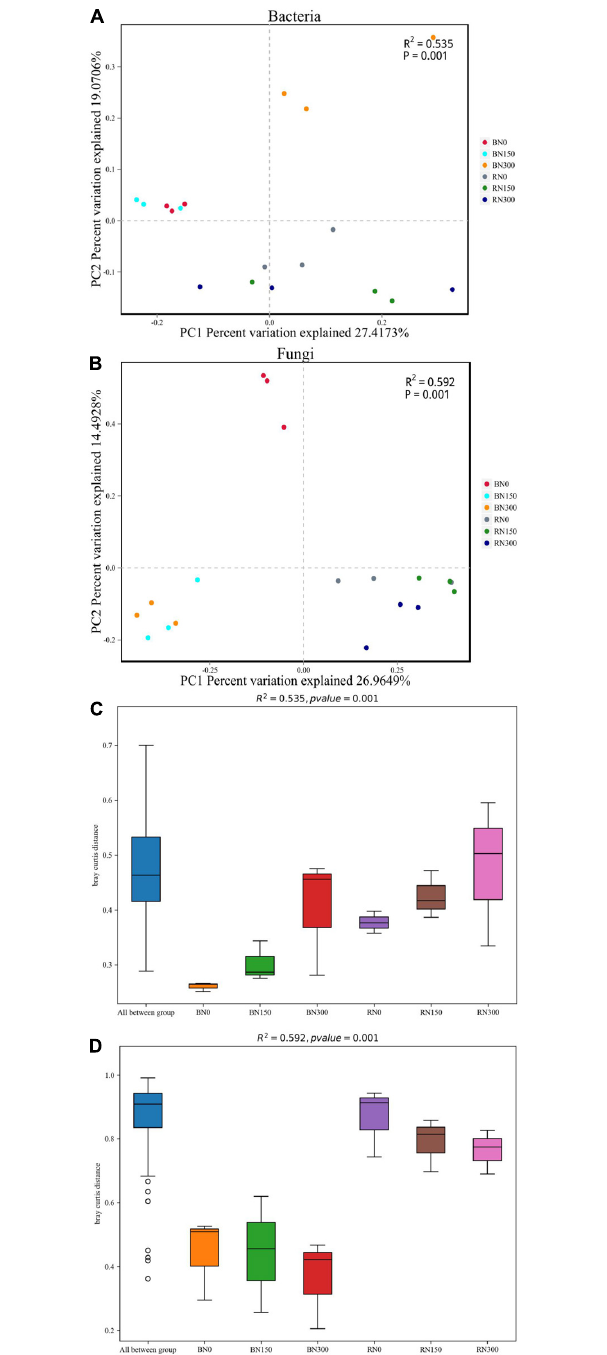
FIGURE 2 | Principle coordinate analysis (PCoA) of the bacterial (A) and fungal (B) communities in rhizosphere and bulk soil samples. Dissimilarity distances showing the differences in bacterial (C) and fungal (D) communities, in rhizosphere and bulk soil samples. PCoA and dissimilarity distances were based on the Bray-Curtis distance algorithm at the OTU level. BN0 and RN0 represent the bulk soil and the rhizosphere soil of rice under N0 treatment; BN150 and RN150 represent the bulk soil and the rhizosphere soil of rice under N150 treatment; BN300 and RN300 represent the bulk soil and the rhizosphere soil of rice under N300